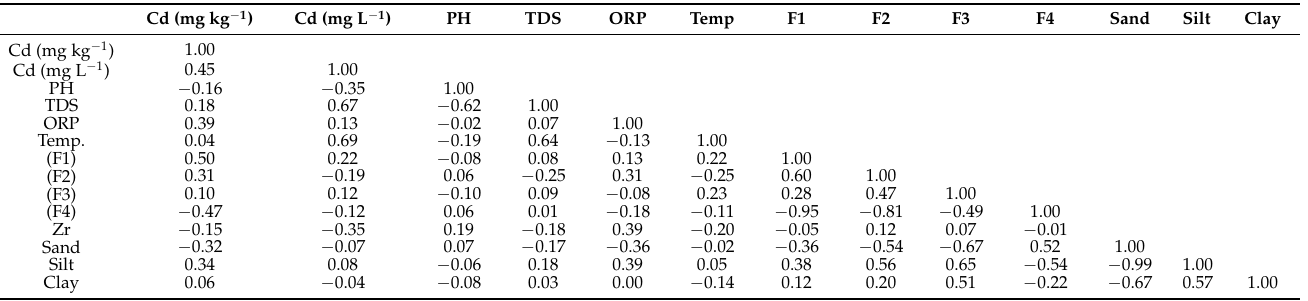
Table 3. Results of the Pearson’s correlation analysis of Nile River sediments and water cadmium concentration with water parameters, Zr, Cd fractions (%), and grain size